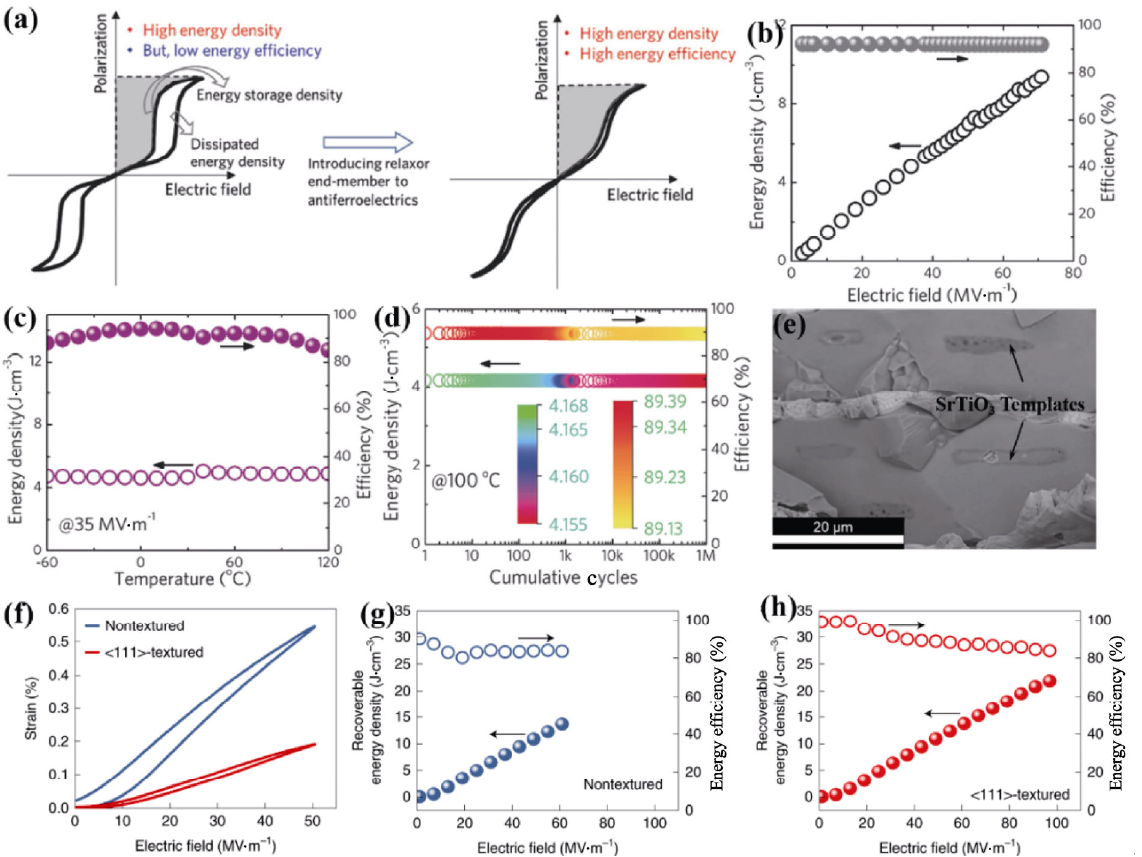
Fig. 32 (a) Schematic diagram for the preparation of relaxor antiferroelectrics. The energy-storage performance as a function of (b) the electric field, (c) the temperature, and (d) the cycles for NBT–0.45SBT MLCCs. (e–g) Cross-section SEM images, strain-electric field curves, and energy-storage performance of nontextured and <111>-textured NBT–0.35SBT MLCCs at room temperature. Reproduced with permission from Ref. [135], © WILEY-VCH Verlag GmbH & Co. KGaA, Weinheim 2018; Ref.